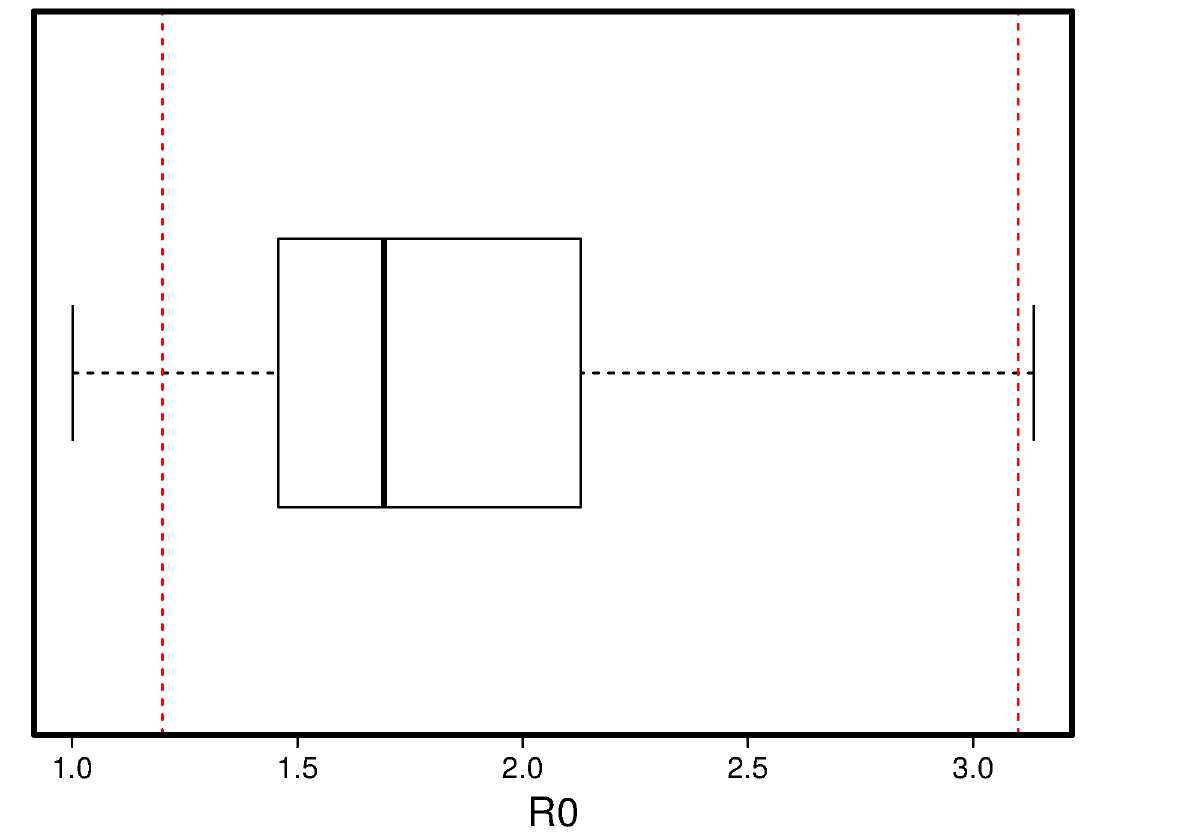
Fig 3. The distribution of R 0 values found by calibration (Red lines represent the range in the